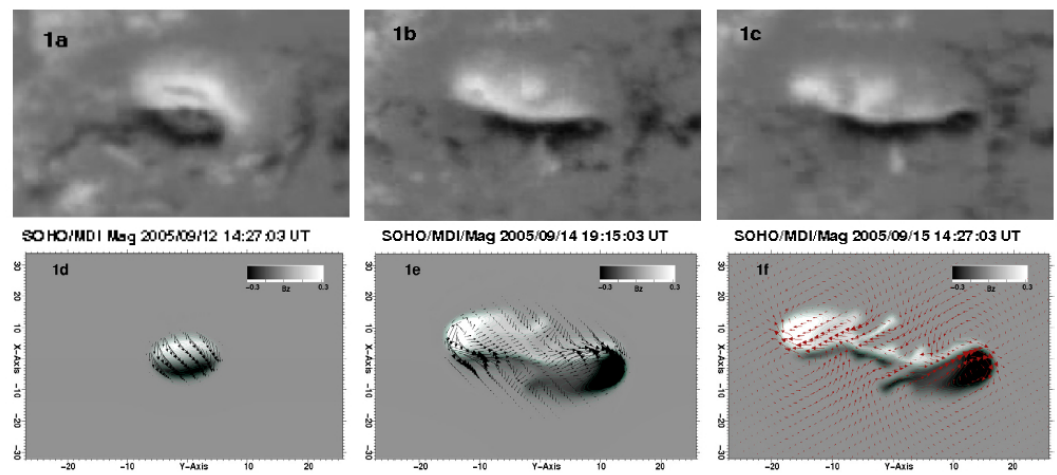
Figure 38: Evidence for twisted flux tube emergence. The top row shows three SoHO/MDI magnetograms of NOAA AR 10808. The positive and negative polarities have ‘magnetic tongue’ morphology. The bottom row shows three synthetic magnetograms from the simulation of the emergence of a twist flux tube. The striking resemblance in morphology suggests a twisted flux rope structure for NOAA AR 10808. Image reproduced with permission from Archontis and Hood (2010), copyright by